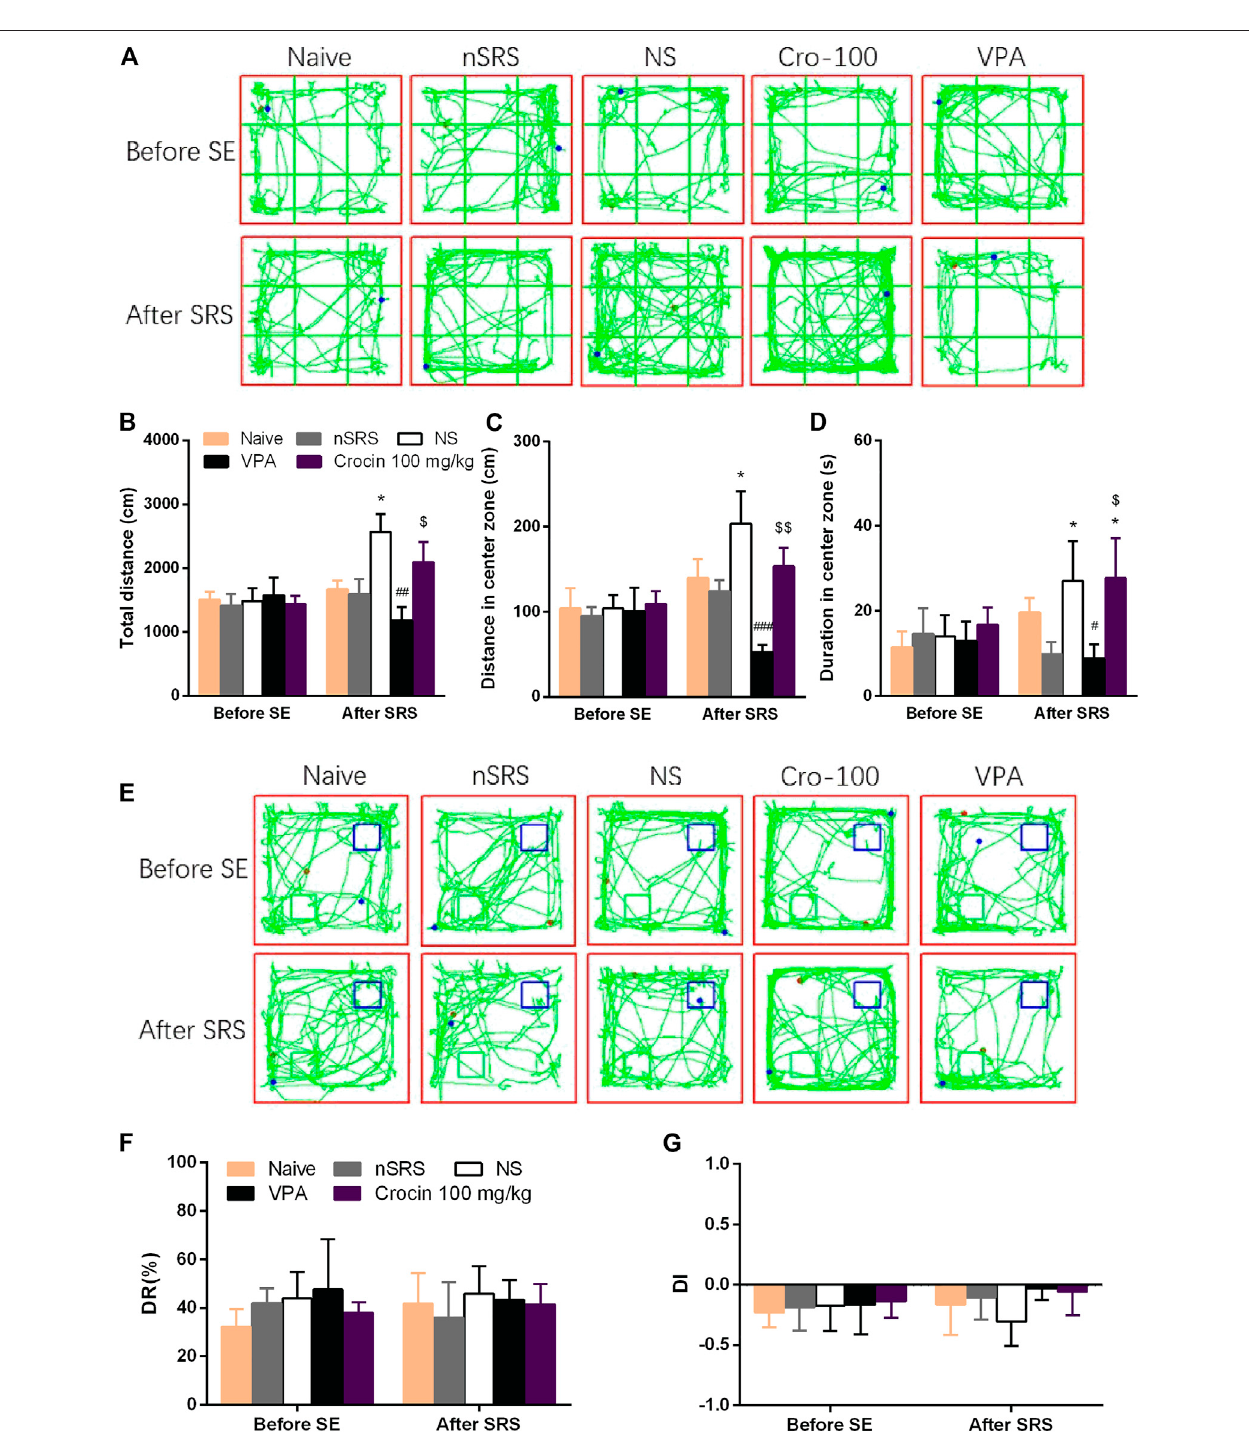
FIGURE5| EffectsofcrocinonthebehaviorsofmiceinOFTandNORT( n =7foreachgroup,x (cid:1) ±S.E.M.). (A) representativetracksofmiceinOFT; (B) totaltravelling distance of mice in OFT; (C) movement distance of mice in center zone in OFT; (D) duration of mice staying in center zone in OFT; (E) representative tracks of mice in NORT(blueboxesmarkthelocationofoldobjectandgreenboxesmarkthelocationofnovelobject); (F) DRofmiceineachgroup; (G) DIofmiceineachgroup.OFT,the open fi eld test; NORT, the novel object recognization test; DR, discrimination ratio; DI, discrimination index; SE, status epilepticus; SRS, spontaneous recurrent seizures; nSRS, non-SRS; NS, normal saline; VPA, sodium valproate. Values are from 3 independent experiments. * p < 0.05, compared with nSRS group; # p < 0.05, ## p < 0.01, ### p < 0.001, compared with NS group (with SRS); $ p < 0.05, $$ p < 0.01, compared with VPA group. Two-way ANOVA was performed for (B,C,D,F,G) .